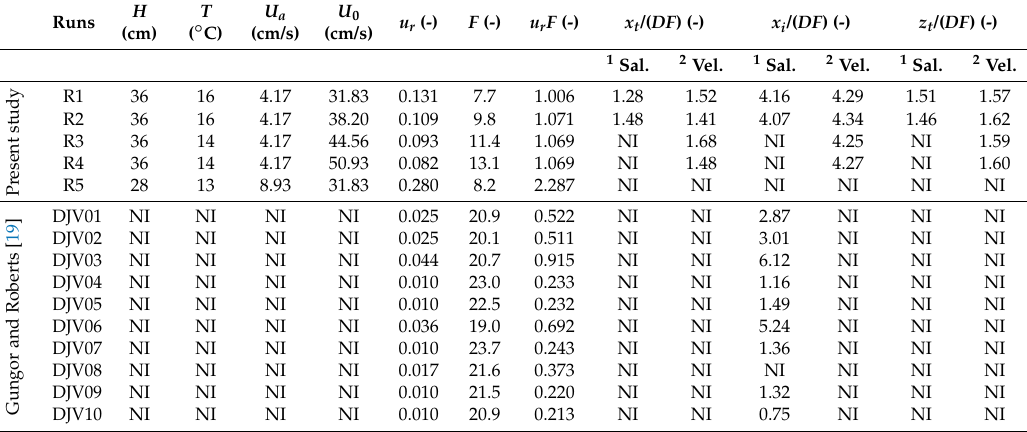
Table 1. Initial experimental conditions and parameters of the investigated